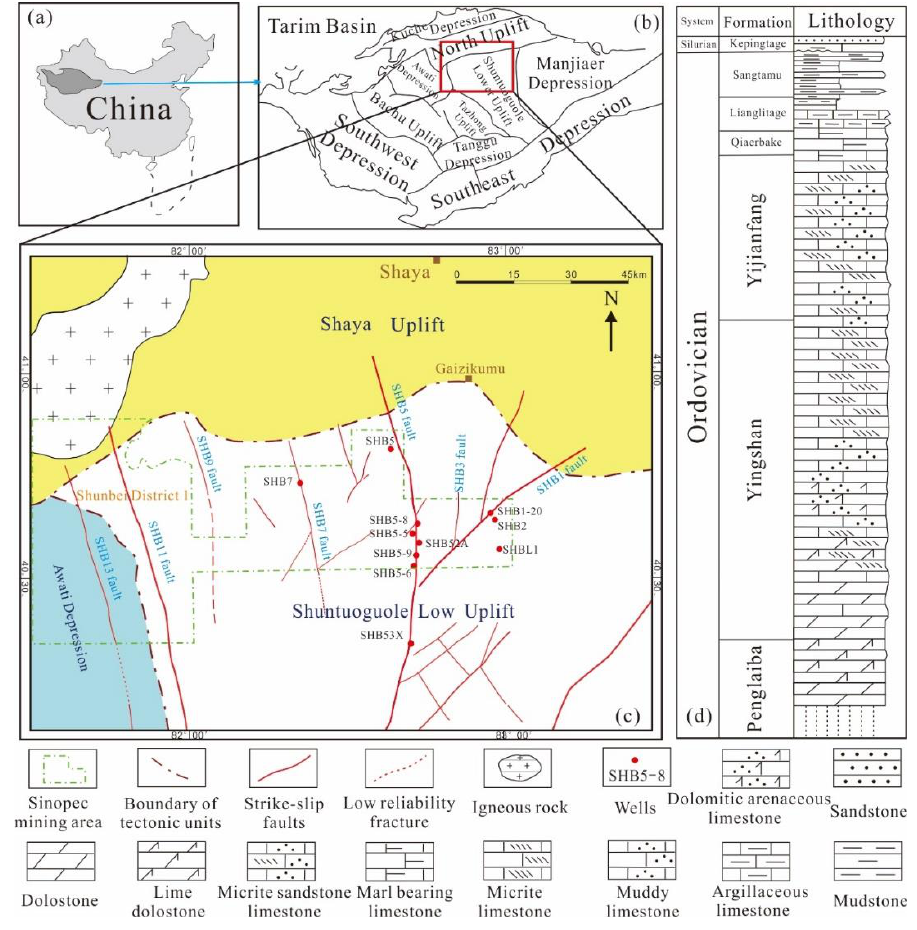
Figure 1. The location of the study area within the Tarim Basin and the regional stratigraphic column of the Ordovician formation (Modified after [17]).